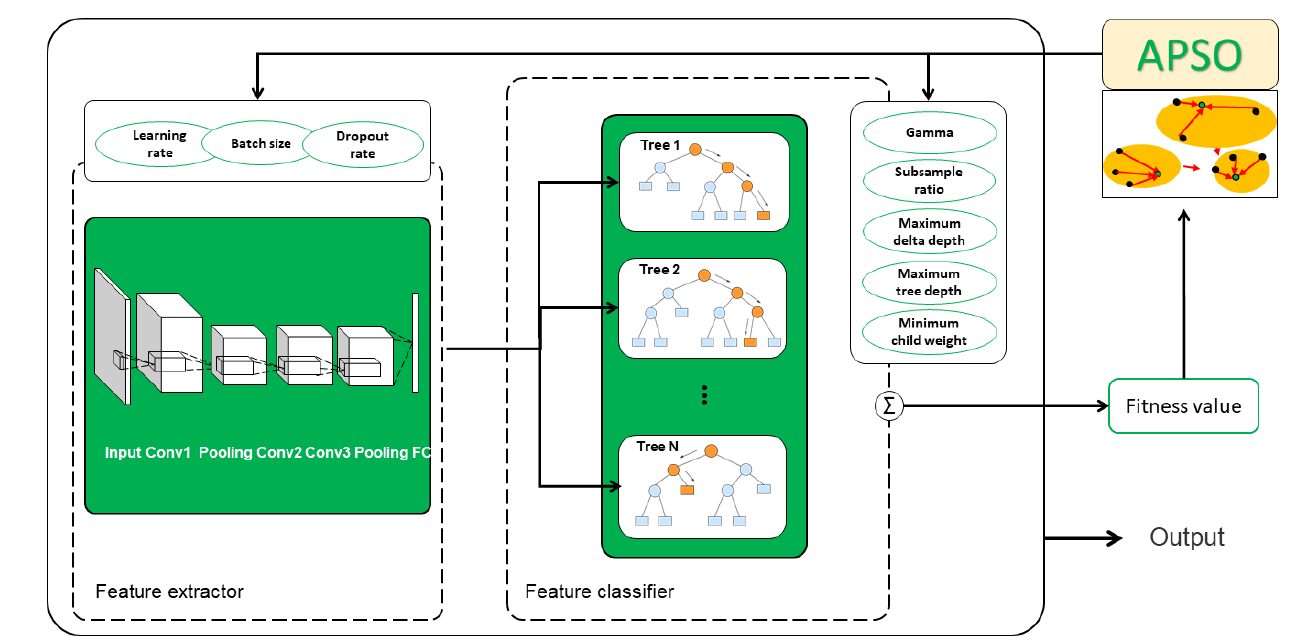
Figure 1. CNN-XGBoost based on APSO image classification